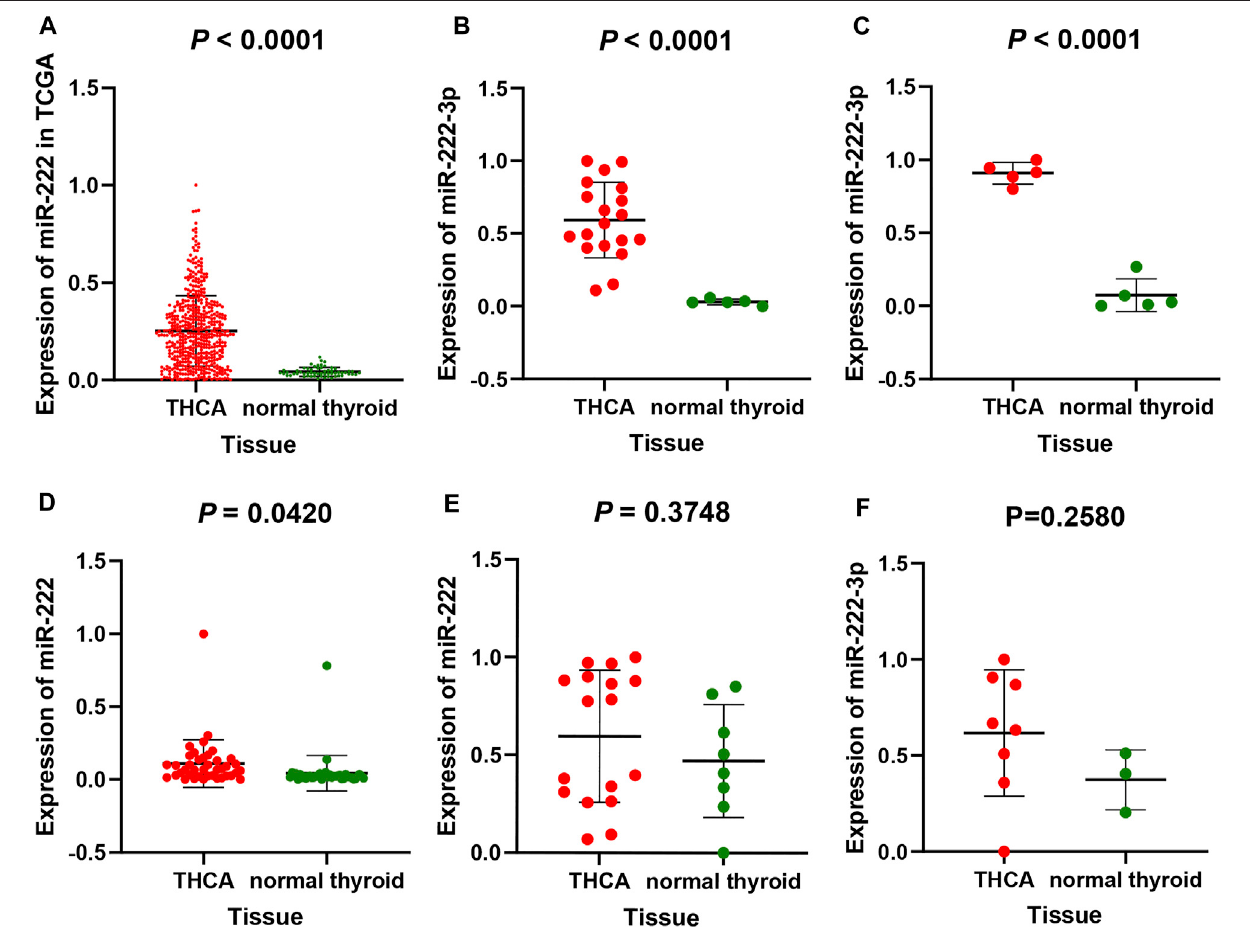
FIGURE 1 | miR-222-3p differential expression in THCA and non-cancerous tissues based on TCGA database (A) and GEO database, including gse73182 (B) , gse113629 (C) , gse40807 (D) , gse62054 (E) and gse97070 (F) dataset. FA stands for thyroid follicular adenoma.